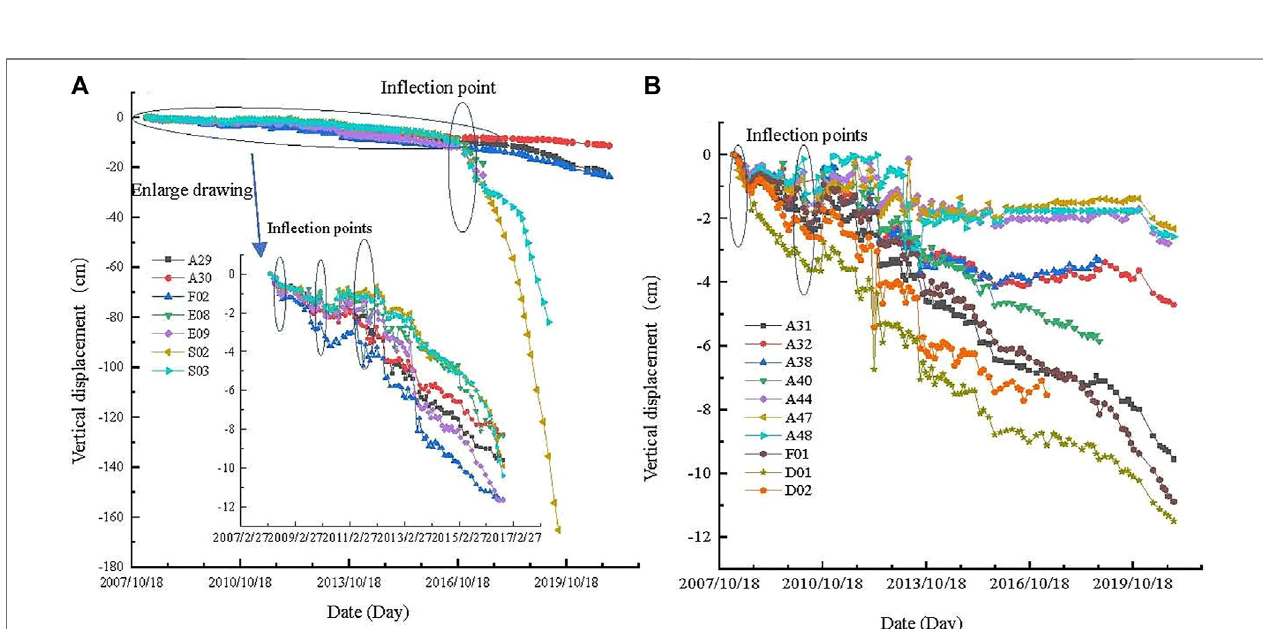
FIGURE 7 | Vertical displacement – time curves (A) With four in fl ection points. (B) With two in fl ection points.